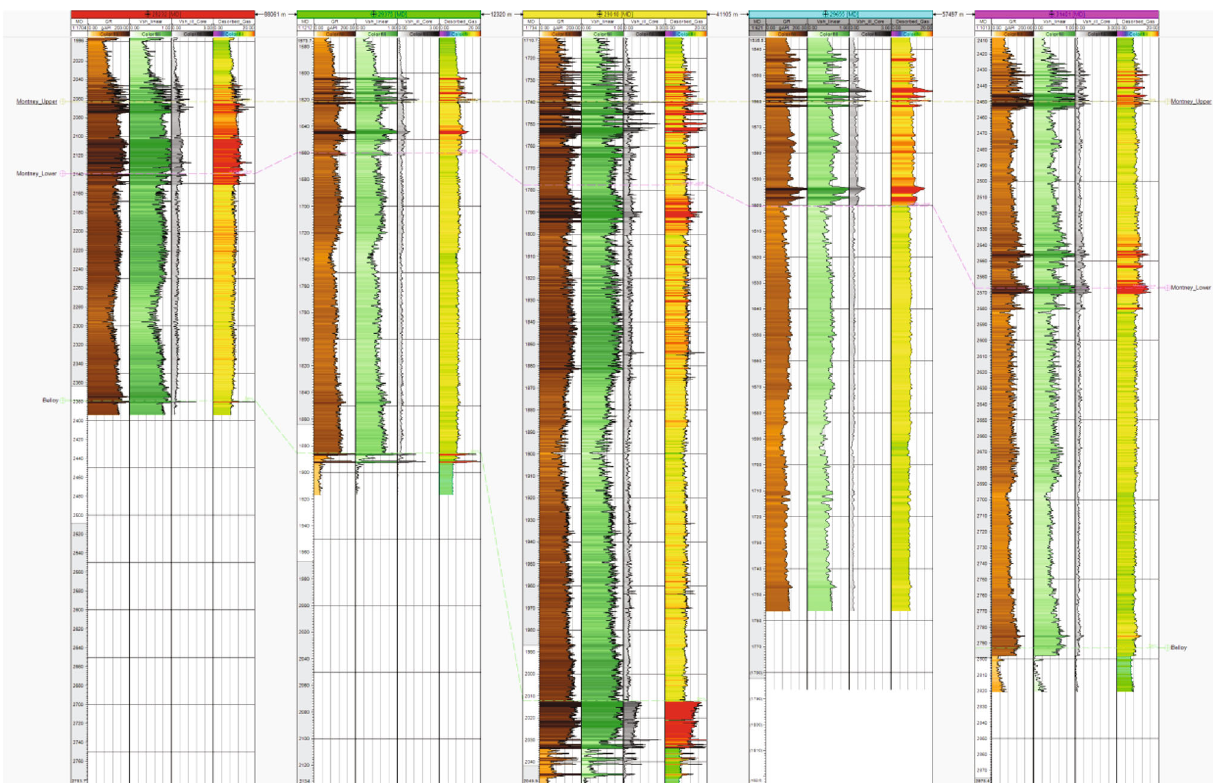
Figure 8: Well-log stratigraphy cross section representing the upper and lower zone of Montney Formation and Belloy Formation of fi ve wells (WA 28232, 29010, 29375, 29655, 31401) of northwestern area. Upper Montney Formation is fl attened. Column display is equal to Figure